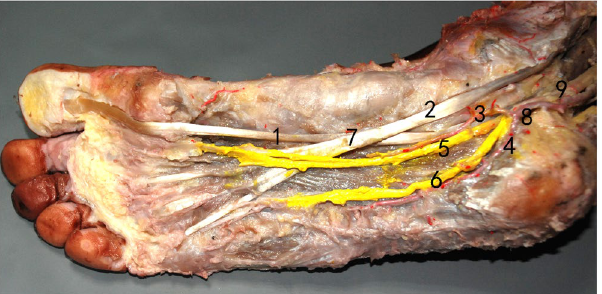
Figure 2. The distance between the medial plantar nerve and Henry’s knot in Pattern 1 (1). FHL, (2). FDL, (3). medial plantar nerve, (4). lateral plantar nerve, (5). medial plantar artery, (6). lateral plantar artery, (7). Henry’s knot, (8). posterior tibial artery, (9). tibial nerve.